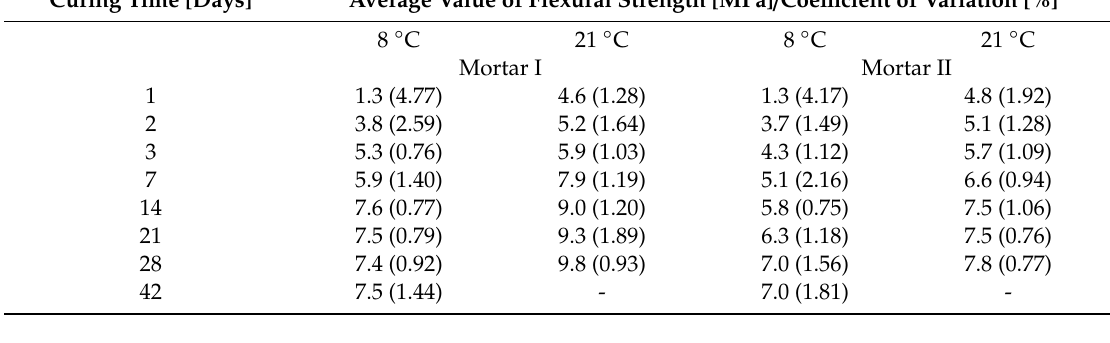
Table 6. Average value of flexural strength and coefficient of variation of mortars cured at 8 °C and 21 °C, following subsequent curing periods.